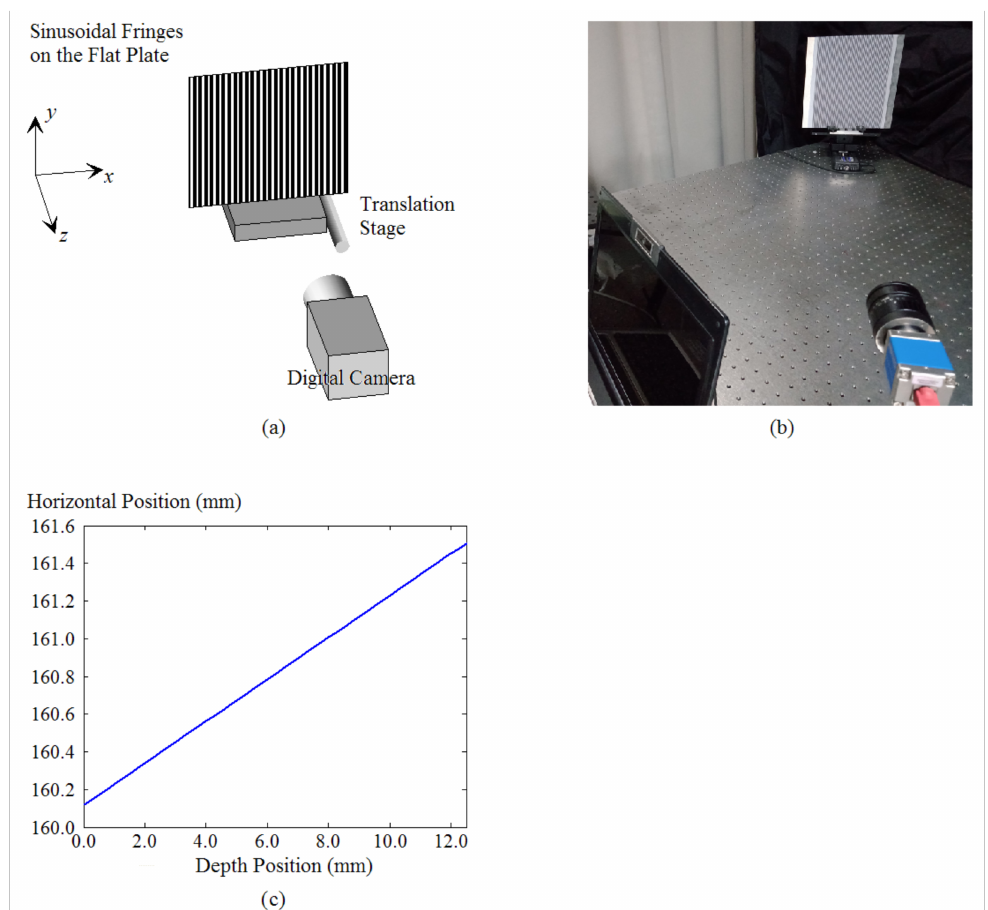
Figure 8. ( a ) An optical configuration for lateral calibrations. ( b ) A photo illustrating the experimental setup. ( c ) A correspondence between x and z for a selected image